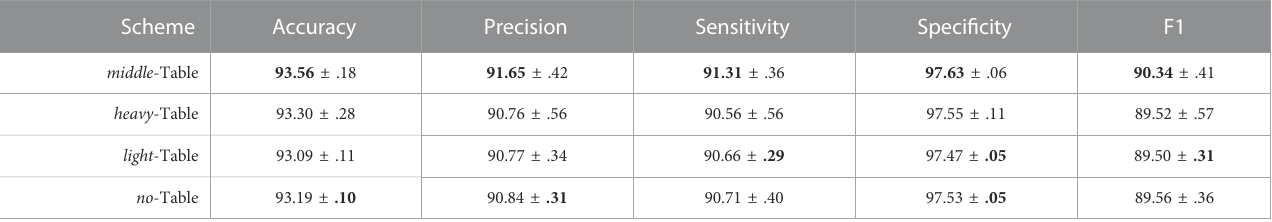
TABLE 4 Ablation study of the look-up table. Besides the middle -Table, which was our fi nal choice, we tried to extend the label assigning to the extreme, namely through the heavy -Table and light -Table schemes. The goal of the no -Table is to examine the effects of candidate image I c . Scheme